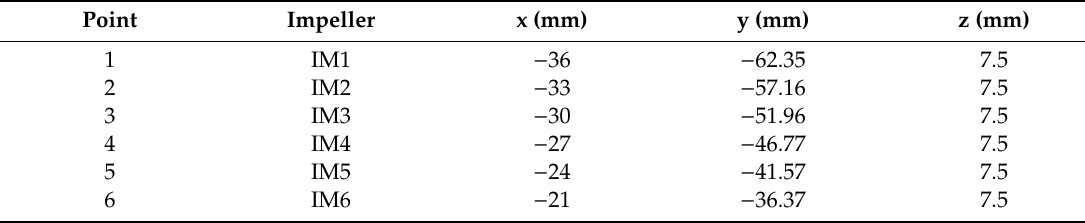
Table 2. Position of monitoring